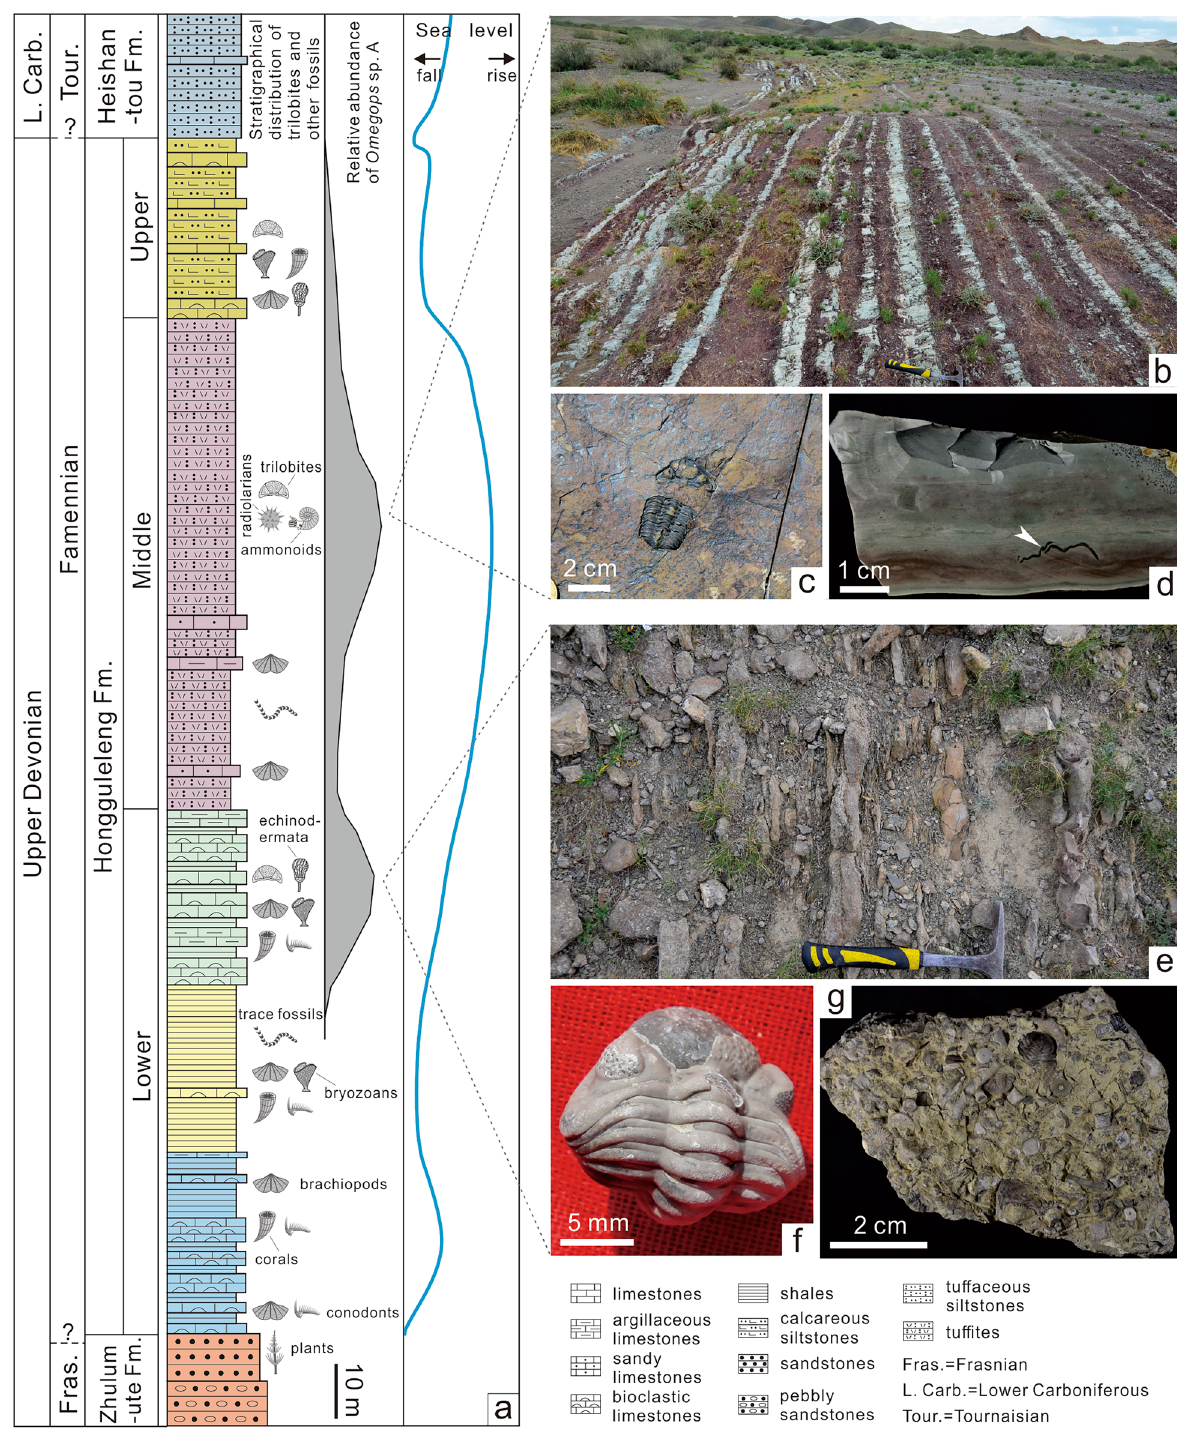
Figure 1. Comprehensive stratigraphical column of the Hongguleleng Formation, and trilobite-bearing tuffites and bioclastic limestones in western Junggar. ( a ) Stratigraphical distribution of Omegops sp. A and other fossils in the Hongguleleng Formation and the Late Devonian sea-level change curve in the study area. ( b ) Silt- to fine-grained tuffites in the middle part of the MHF in the Bulongguoer section. ( c ) Exuviae of an Omegops sp. A preserved on the bedding surface of the tuffites. ( d ) Vertical section of the trilobite-bearing tuffites. ( e ) Thin-bedded bioclastic limestones, argillaceous limestones and shales unevenly interbedded in the upper part of the LHF. ( f ) enrolled Omegops sp. A from the upper part of the LHF. ( g ) Bioclastic limestones contain trilobite fragments and other